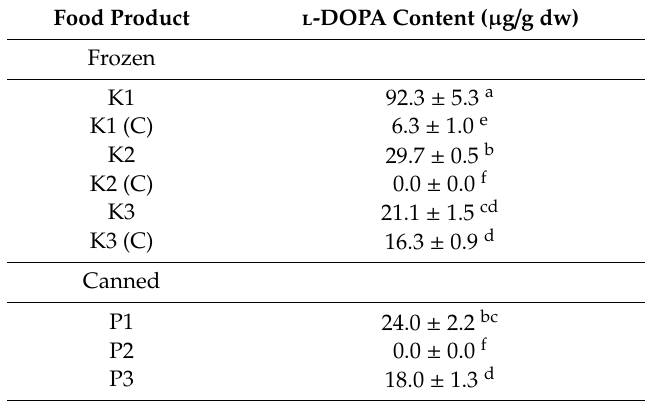
Table 5. l -DOPA content in the food products obtained after extraction A